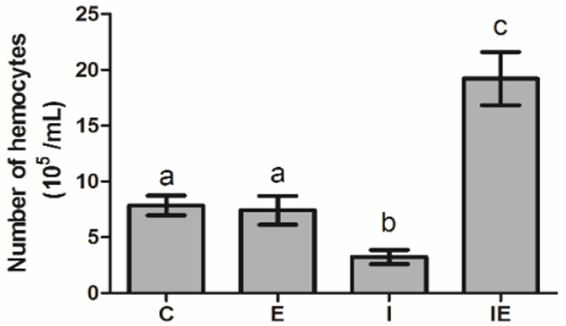
Figure 1. Effect of the E uphorbia milii latex exposure on the number of total circulating hemocytes in the uninfected and infected Biomphalaria glabrata by Schistosoma mansoni . C- Control group; E- Exposed group; I – Infected and unexposed and IE – Infected and exposed. Different letters, significant